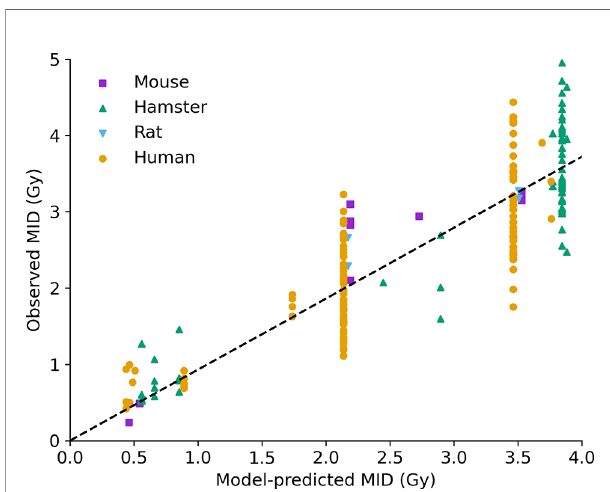
FIGURE 4 | Intrinsic radiosensitivity predictions. Predicted MID for acute X- ray irradiation (x-axis) is compared to observed MID (y-axis) for a range of cell lines (points, coloured by species of origin). The model effectively captures the impact of a range of modi fi cations on radiosensitivity. Best fi tting slope line has a slope of 0.93, and an R 2 of 0.75.